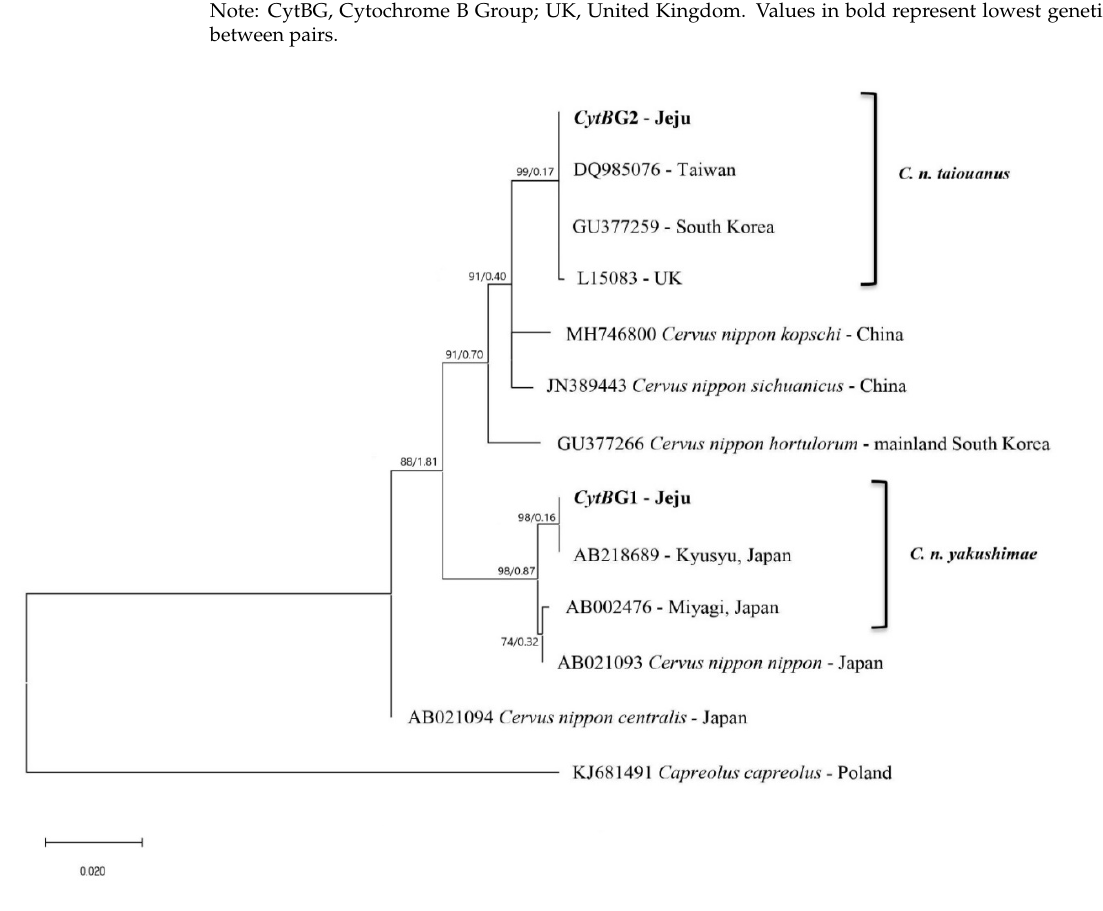
Table 2. Pairwise genetic distance between the haplotypes of C. nippon.